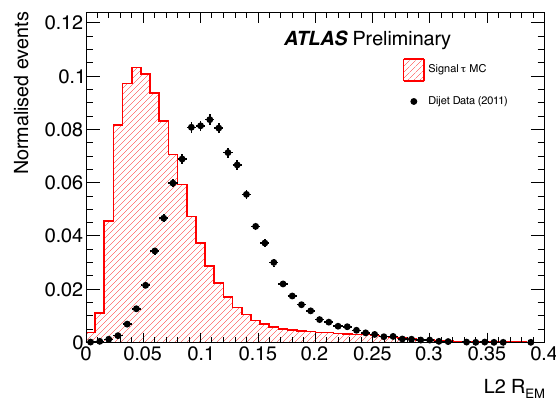
Fig. 1. Electromagnetic radius, R em , for trigger taus in signal Monte Carlo and QCD di-jet data. The latter serves as back- ground estimate